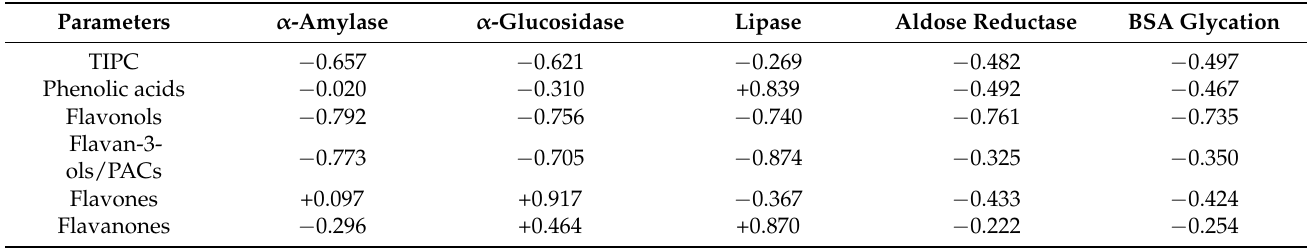
Table 3. Correlation coefficients (r) observed among phenolic composition of Lauraceae leaf extracts and evaluated in vitro